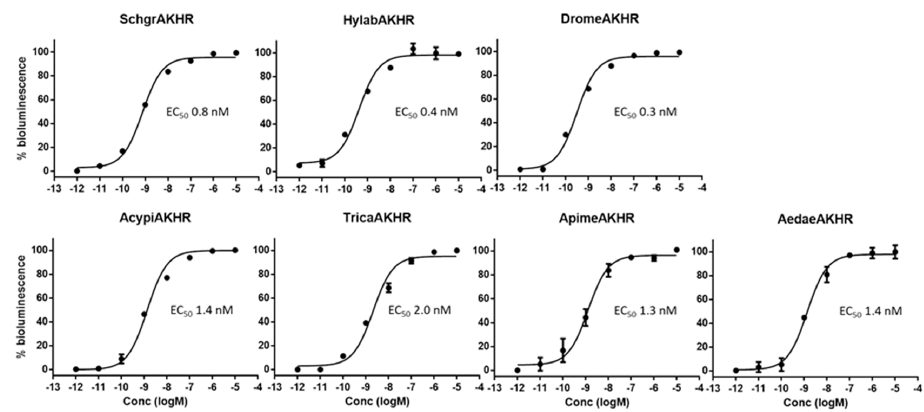
Figure 3. Dose–response curves of the endogenous AKHs with their respective cognate AKH receptors in vitro. The receptors were expressed in CHO cells and tested in an aequorin-based bioluminescent receptor assay. Data are shown as mean ± SD, each experiment was performed at least in duplicate, and % bioluminescence is a proxy for receptor activation. Values indicated on the x -axis refer to the logarithm of the ligand concentration (expressed in molar). Values indicated on the y -axis are the percentage relative to the maximal bioluminescence level obtained in the assay, where 100% was defined as the average value obtained when applying high doses (1 and 10 µ M) of the respective AKHs and 0% was defined as the response measured when no peptide was applied (BSA control). Table 1 shows the amino acid sequences of the tested